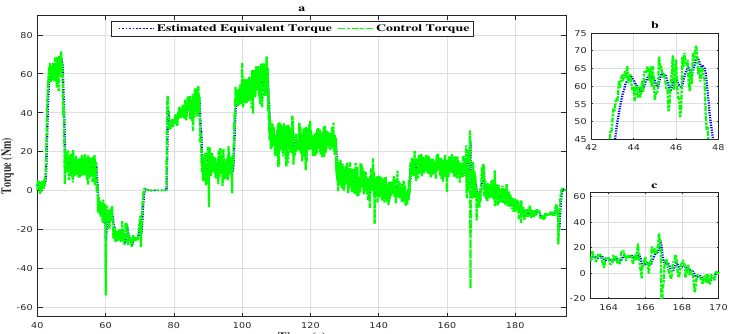
Figure 9. ( a ) Torque evolution of the vehicle with the proportional and integral observer closed loop FTC. ( b ) Zoom in at t ∈ [ 42 s,48 s ] . ( c ) Zoom in at t ∈ [ 163 s,170 s ] .